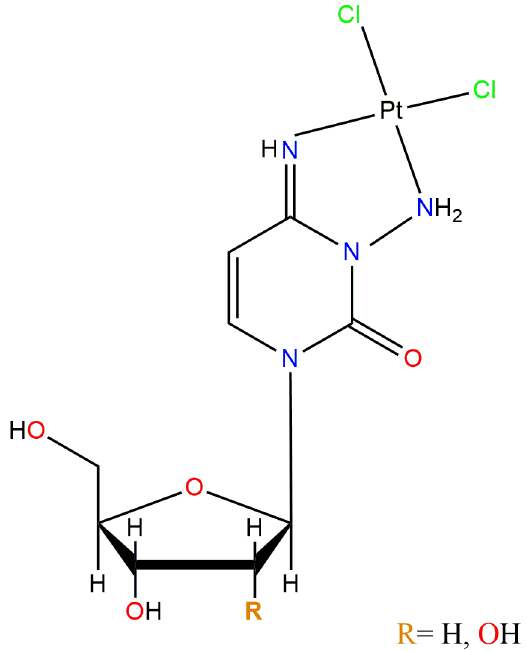
Figure 6. Chemical structure of 3-amino- 2′ -deoxycytidine-dichloridoplatinum(II) and 3-aminocyti- dine-dichloridoplatinum(II).